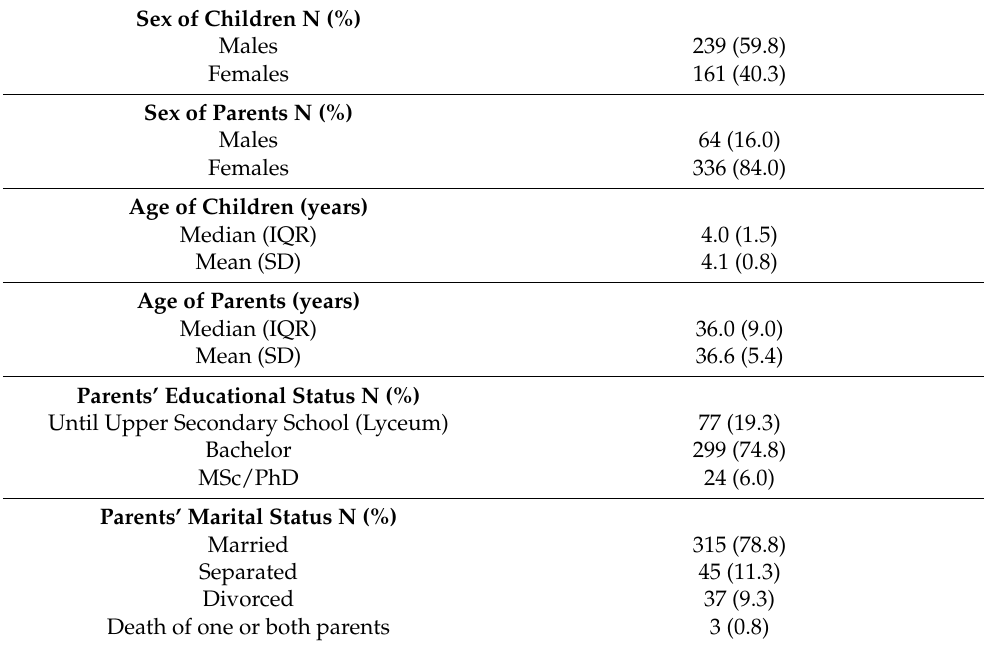
Table 1. Samples’ Sociodemographic characteristics (N =